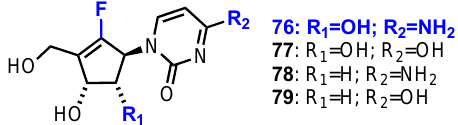
Figure 8. Structures of fluorocyclopentenyl nucleoside analogues 76 – 79 .